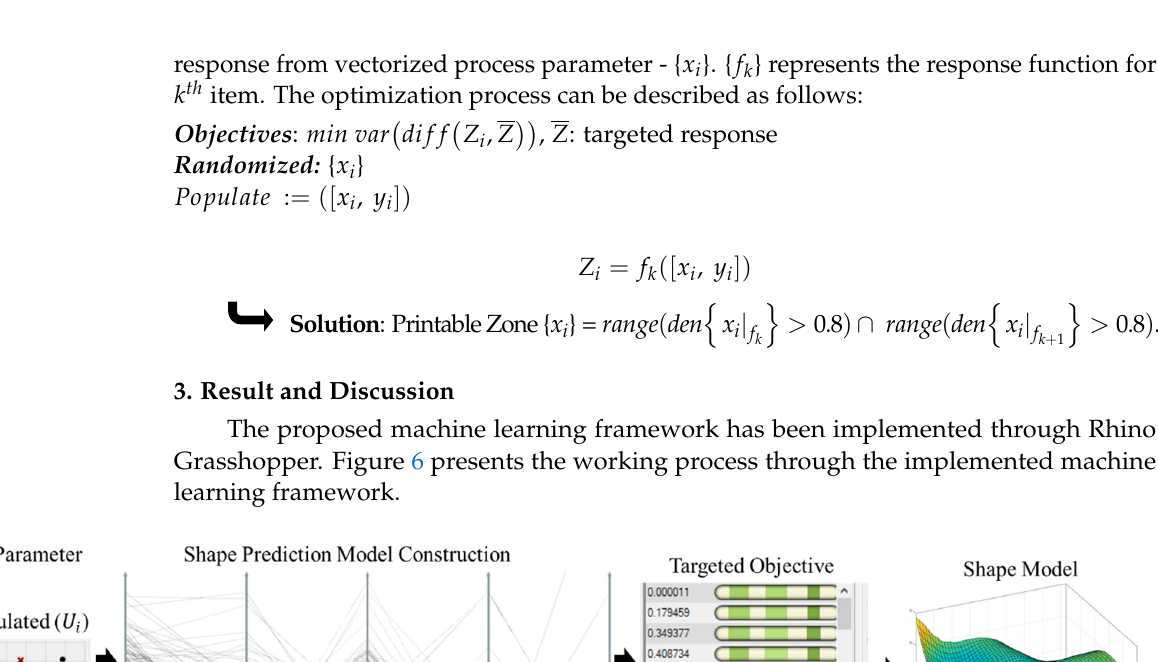
Figure 6. Deposition shape response construction through implemented machine learning framework.